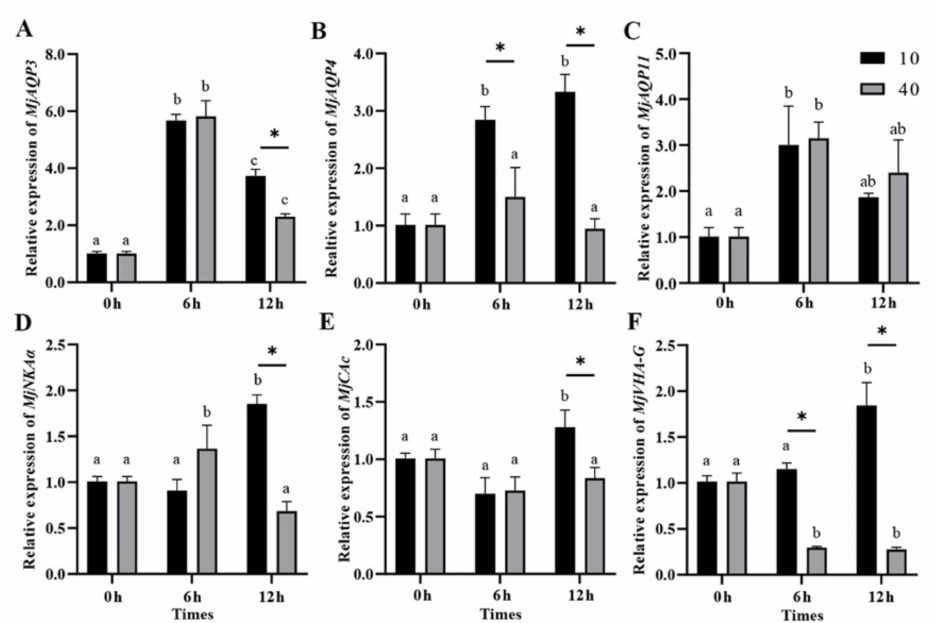
Figure 6. The relative expression levels of ( A ) MjAQP3 , ( B ) MjAQP4 , ( C ) MjAQP11 , ( D ) MjNKA α , ( E ) MjCAc , and ( F ) MjVHA-G in the gills at 10‰ and 40‰ salinity stresses. The relative expression level of each gene at 0 h is separately used as calibrator. The data are presented as mean + SD ( n = 3). Lowercase letters indicate significant differences ( p < 0.05) with the same salinity at different exposure times. Asterisks above black bars denote significant differences ( p < 0.05) among different salinities at the same treatment